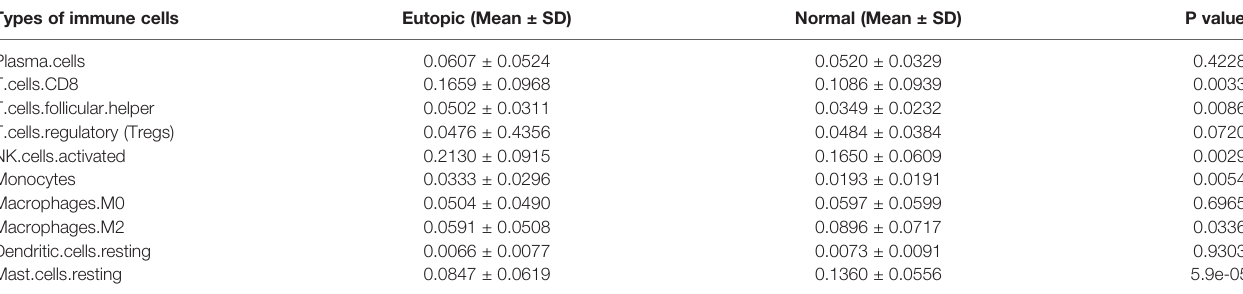
TABLE 2 | The proportions of 10 major in fi ltrating immune cell subsets in the endometrium with or without endometriosis estimated by CIBERSORT. Types of immune cells Eutopic (Mean ± SD) Normal (Mean ±